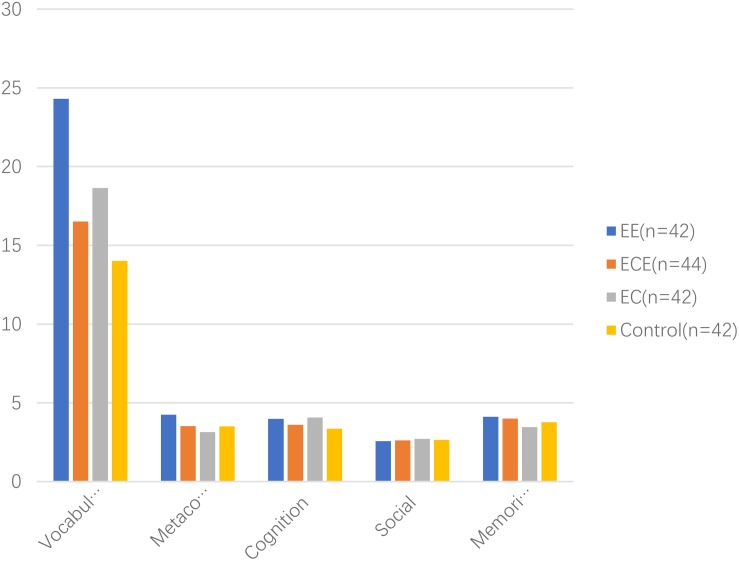
Post-test results.